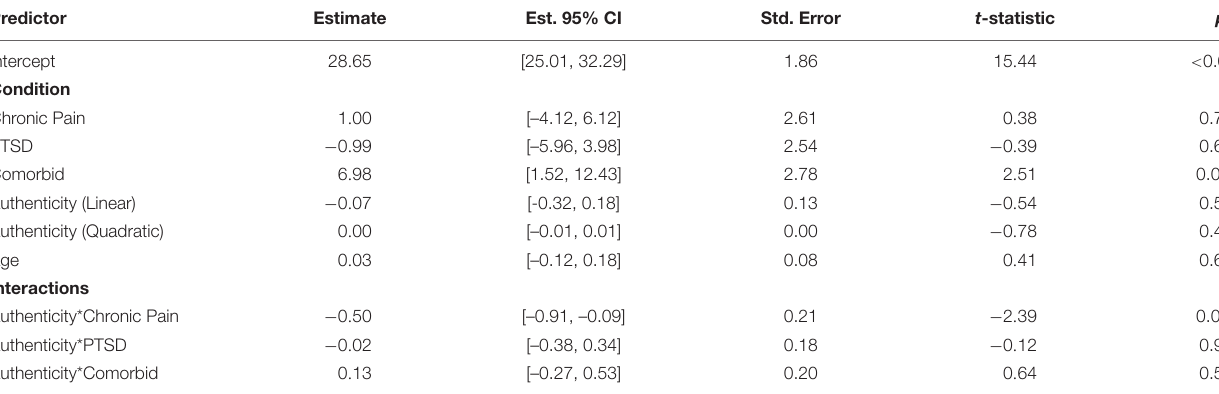
TABLE 3 | Regression estimates – CV-19